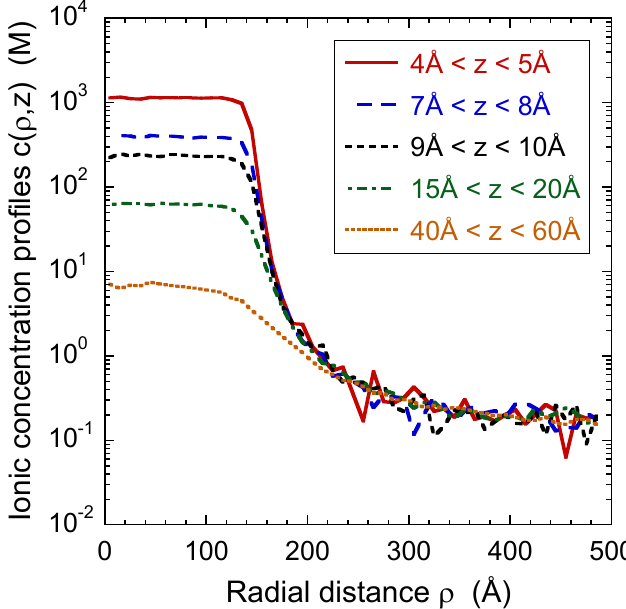
Figure 13. Ionic concentration profiles evaluated by Monte Carlo numerical simulations illustrating Li + ions condensation around an isolated laponite platelet. Reprinted with permission from Ref. [41]. Copyright (2009) American Chemical